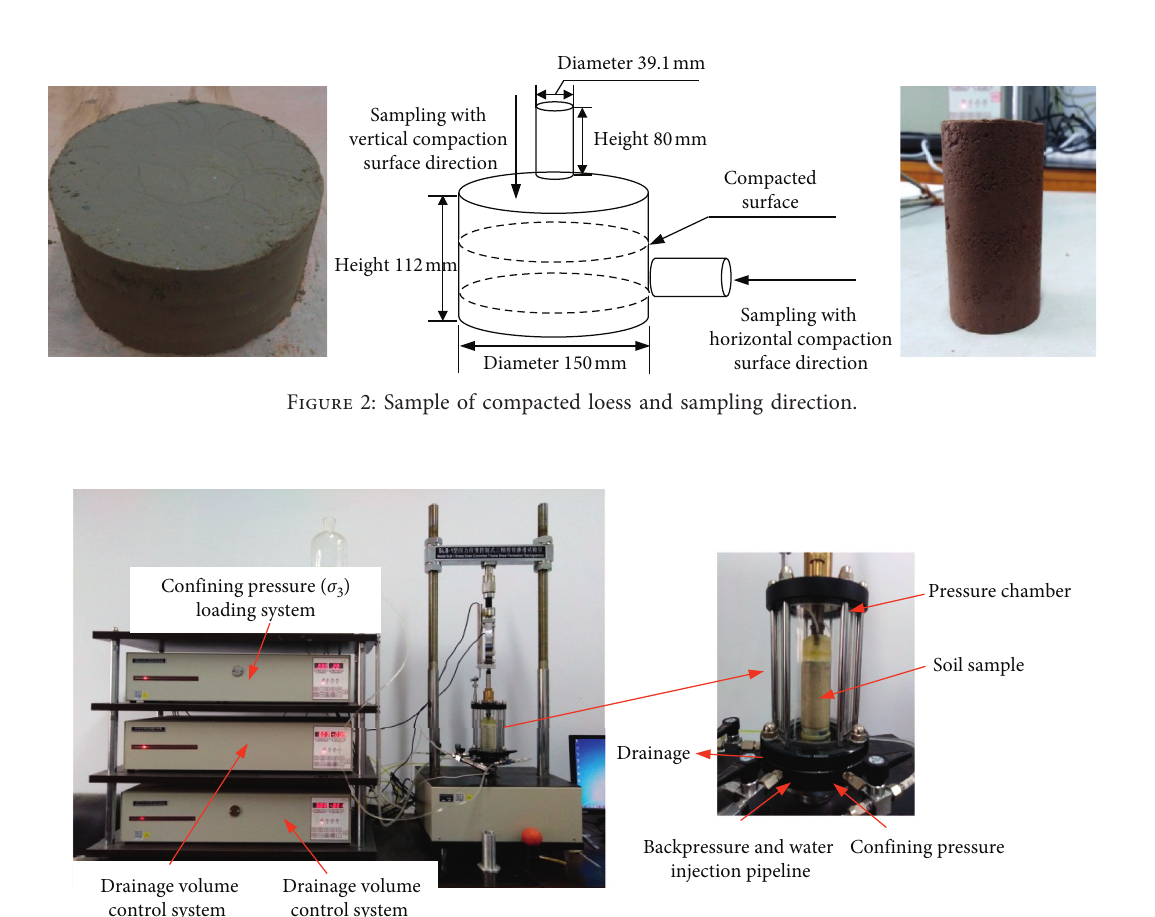
Figure 3: SLB-1 triaxial permeameter test apparatus.